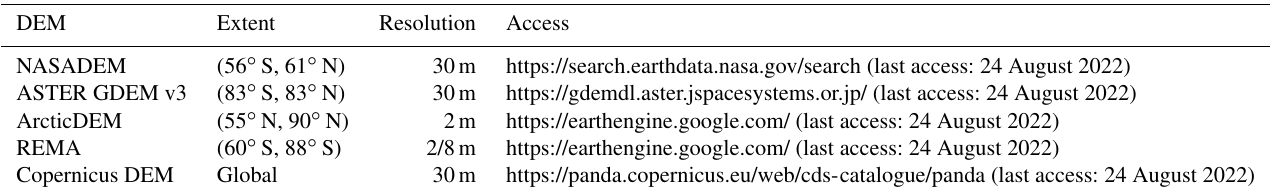
Table 1. All DEMs collected in this study.